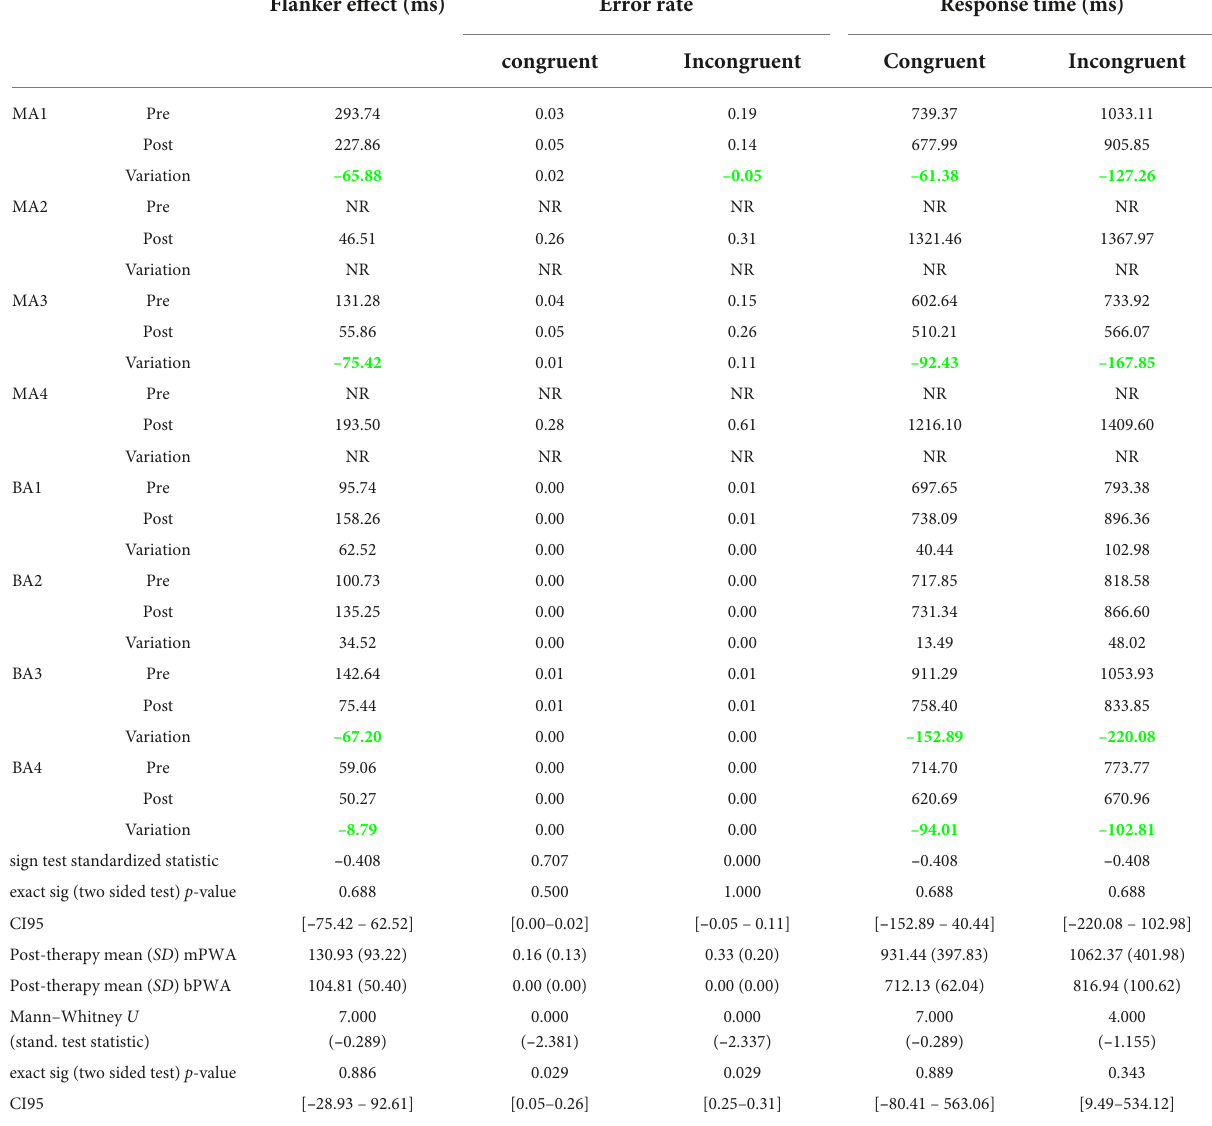
TABLE 5 Pre-therapy and post-therapy Flanker task outcome measure performances, exact sign test results testing the statistical difference between pre- and post-therapy, and Mann–Whitney U testing if groups significantly differ